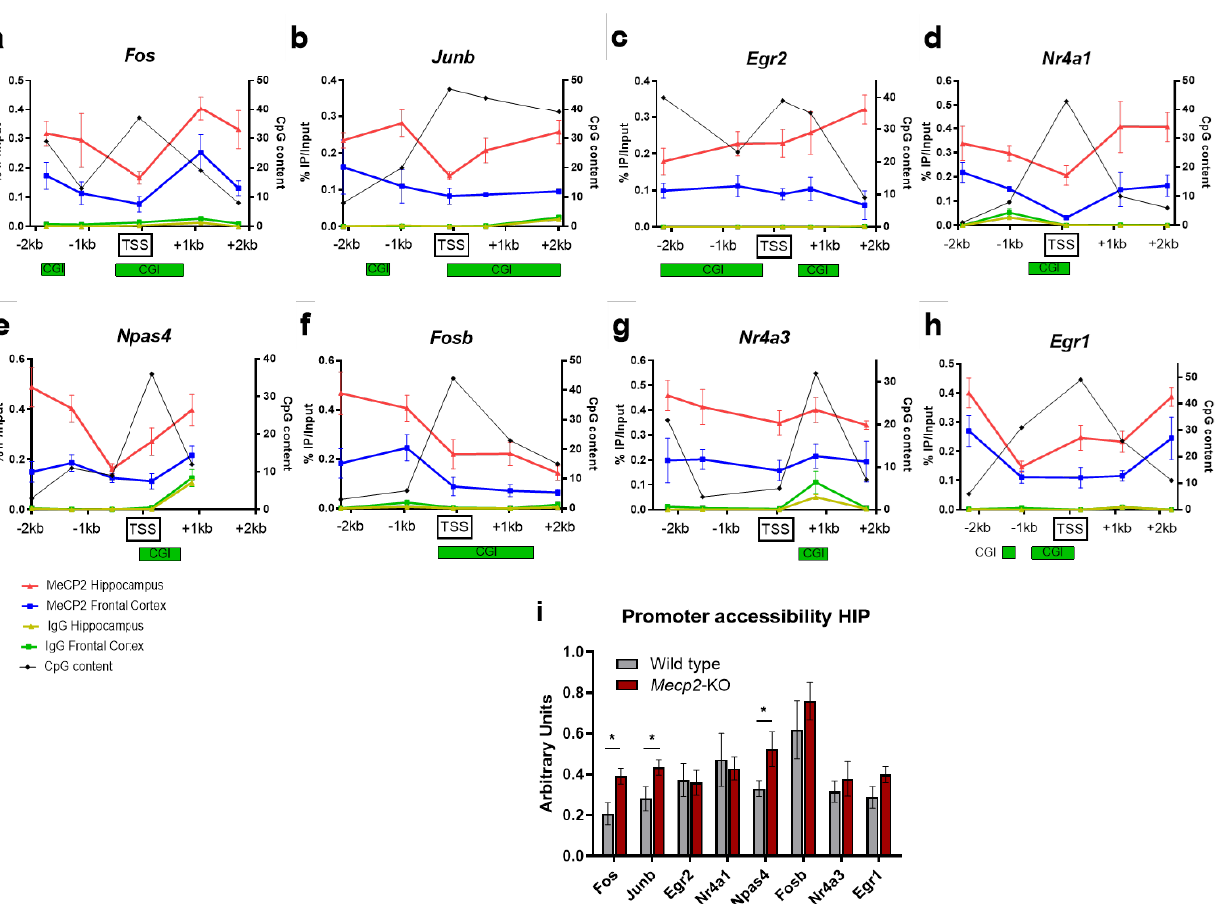
Figure 2. MeCP2 has a potential repressive role on IEGs. ( a – h ) Five regions encompassing each gene’s transcription start site were analyzed with quantitative chromatin immunoprecipitation–PCR (ChIP–qPCR) in the hippocampus of 8–week WT mice. Green boxes below each graph represent CpG islands (taken from UCSC genome browser, GRCm39/mm39). Values are expressed as the percentage of MeCP2 or IgG enrichment over the input on the left y –axis ( n = 3–4 biological replicates for each condition, means ± SEM are represented), and the number of CpG dinucleotides in 500 – bp windows on the right y – axis. ( i ) Micrococcal nuclease (MNase) accessibility assay in WT vs. Mecp2 – KO hippocampi. MNase – digested DNA was subjected to quantitative PCR and normalized with input DNA ( n = 3 biological replicates for each condition, means ± SEM are represented, * p < 0.05 in Student’s t -tests).